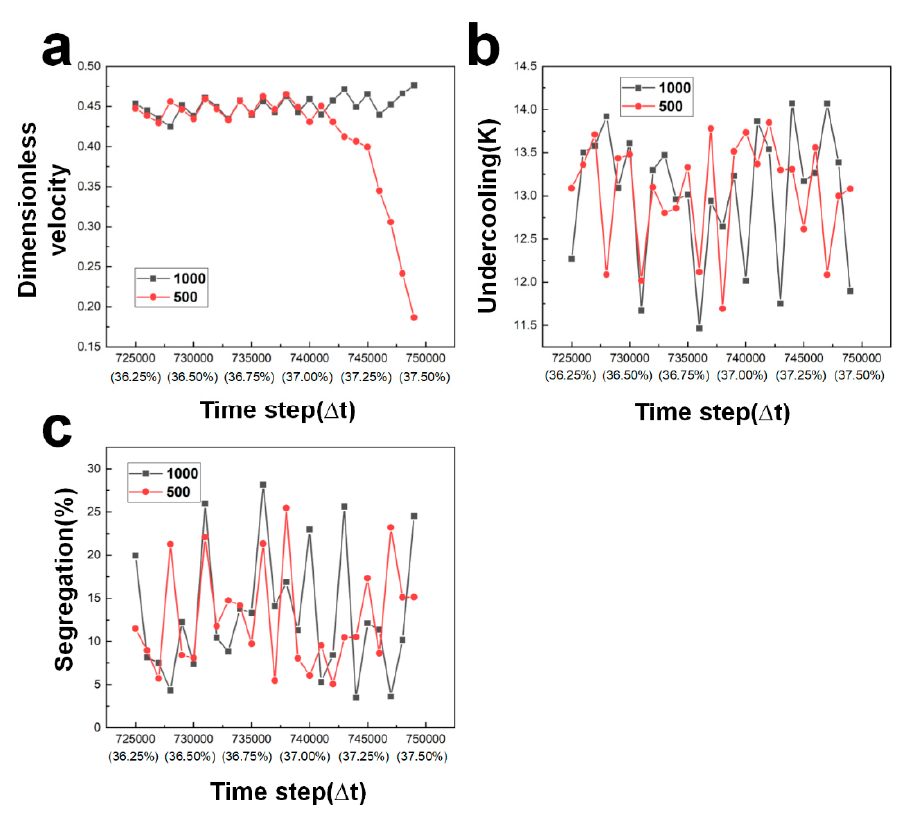
Figure 16. The comparisons of: ( a ) columnar dendrite tip velocity; ( b ) undercooling of dendrite tip; ( c ) solute segregation between case 5 and 6.